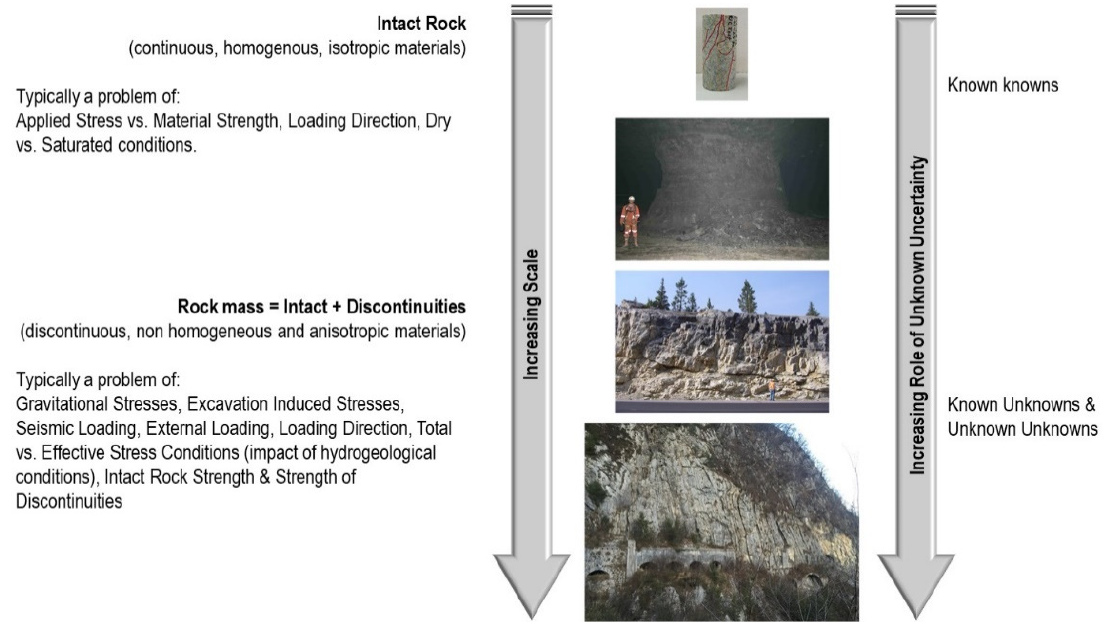
Figure 6. The role of knowns and unknowns in the rock engineering process.